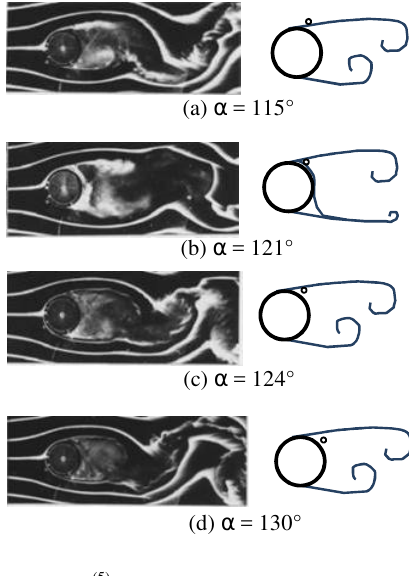
Fig. 4. Flow patterns . (5)